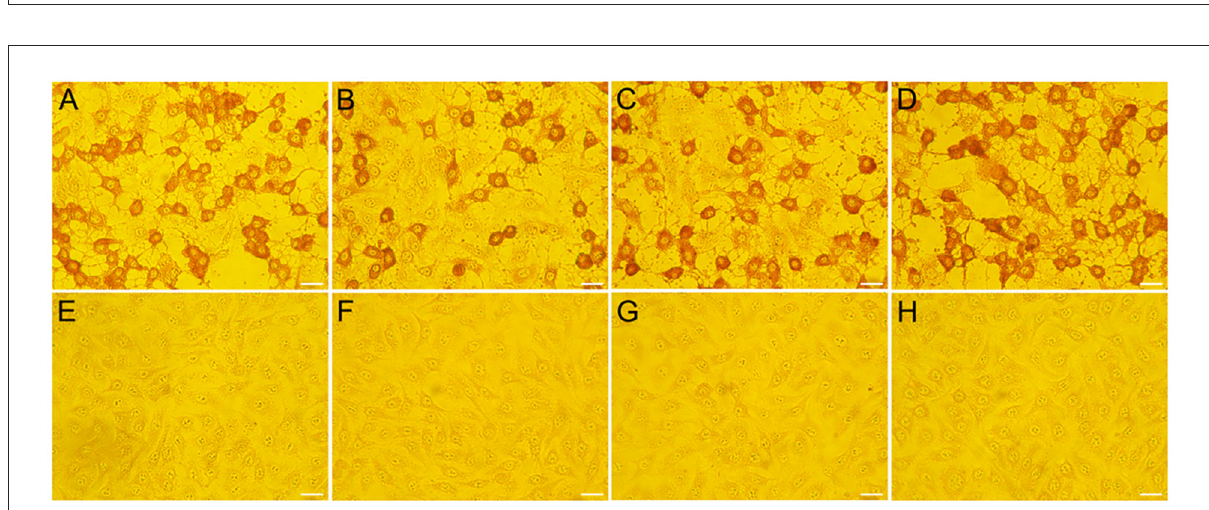
FIGURE7 Confirmation of the representative CEV/OEV virus strain by IPMA. Vero cells infected with specimens were incubated with polyclonal antibody raised in rabbit against CEV-VP1 protein. Strong immunoreactions were observed in the cells inoculated with positive samples (HeN-T3-12, HeN-D1-37, and HeN-D2-57) (A–C) , while no reactions were observed in the cells inoculated with negative samples (E–G) . Vero cells infected by CEV-JL14 (D) and non-infected cells (H) were used as positive and negative controls, respectively. Bar = 20 µ